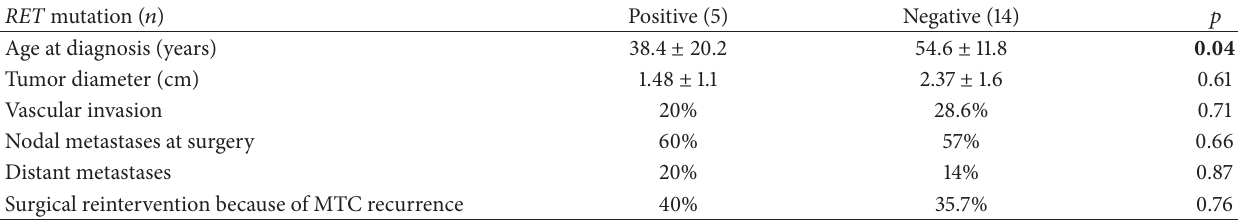
Table 2: Comparison of neoplastic behaviors in patients with MTC according to RET mutation